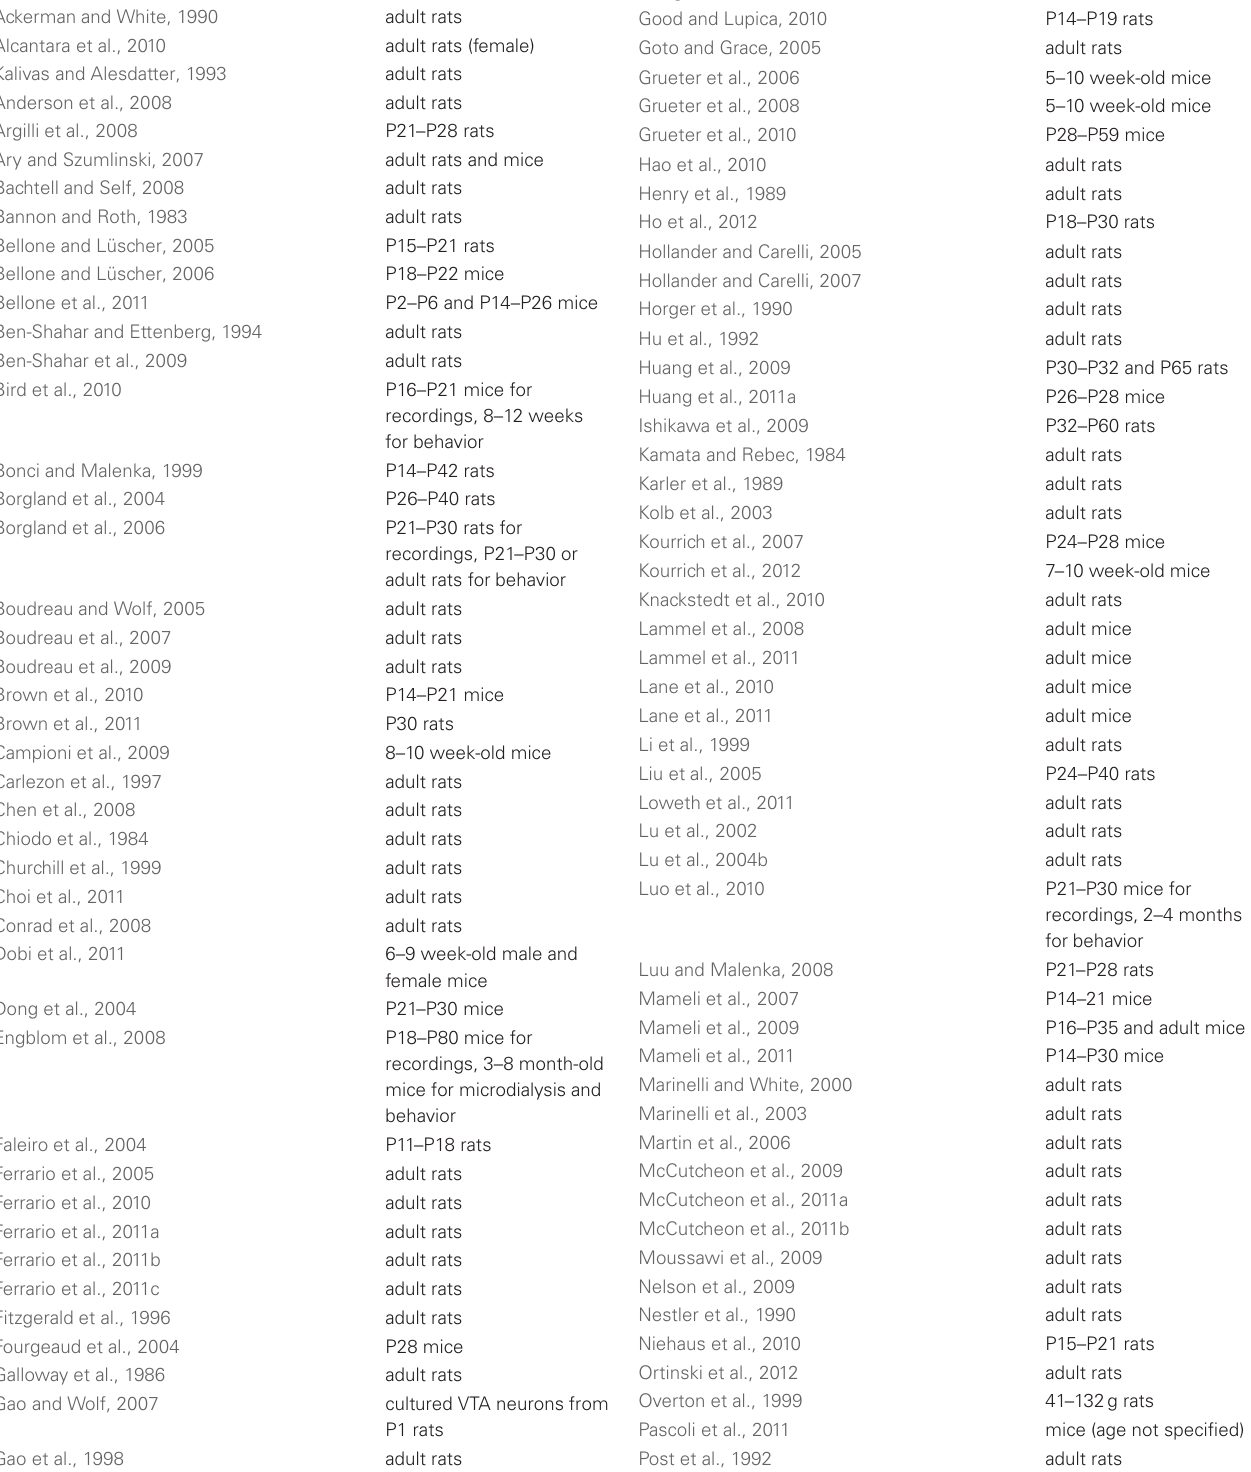
Table 2 | Species and age of experimental subjects in cocaine-related primary papers cited in this review (male animals unless noted otherwise; adult rat = > 300g at time of testing or so described by authors; adult mouse = so described by